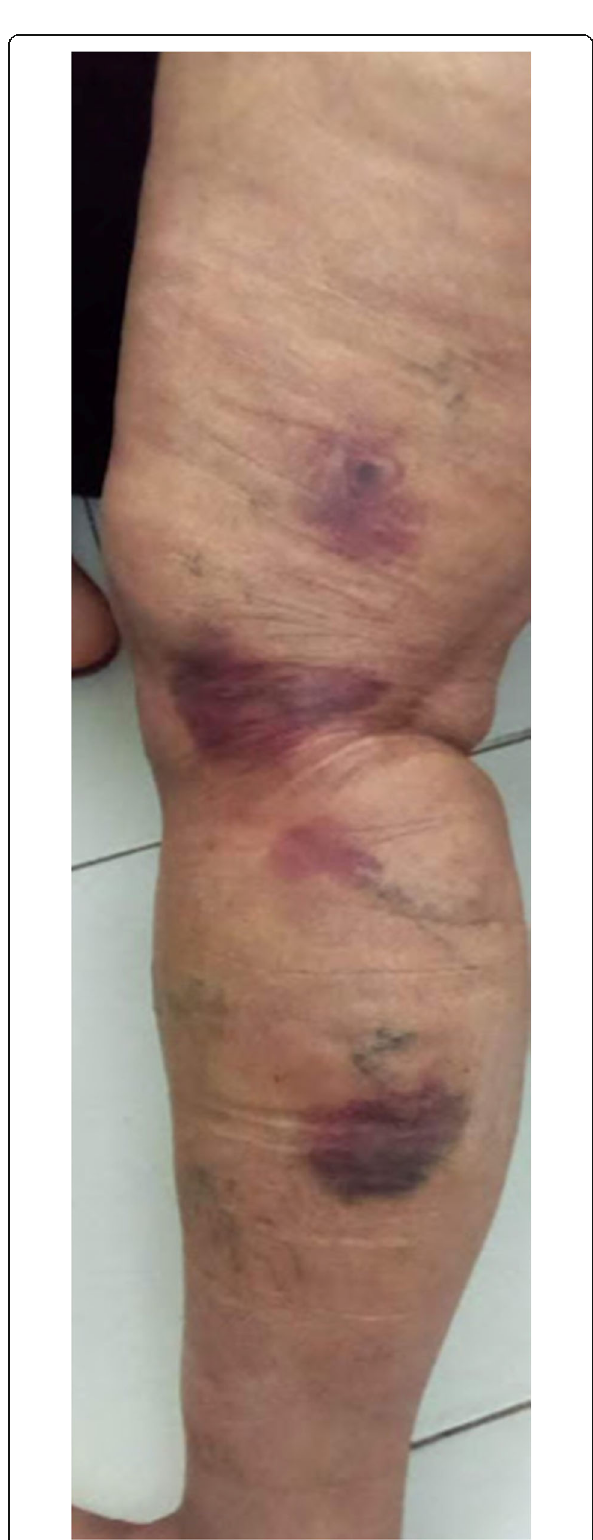
Fig. 5 Post-injection bruises and site coagula